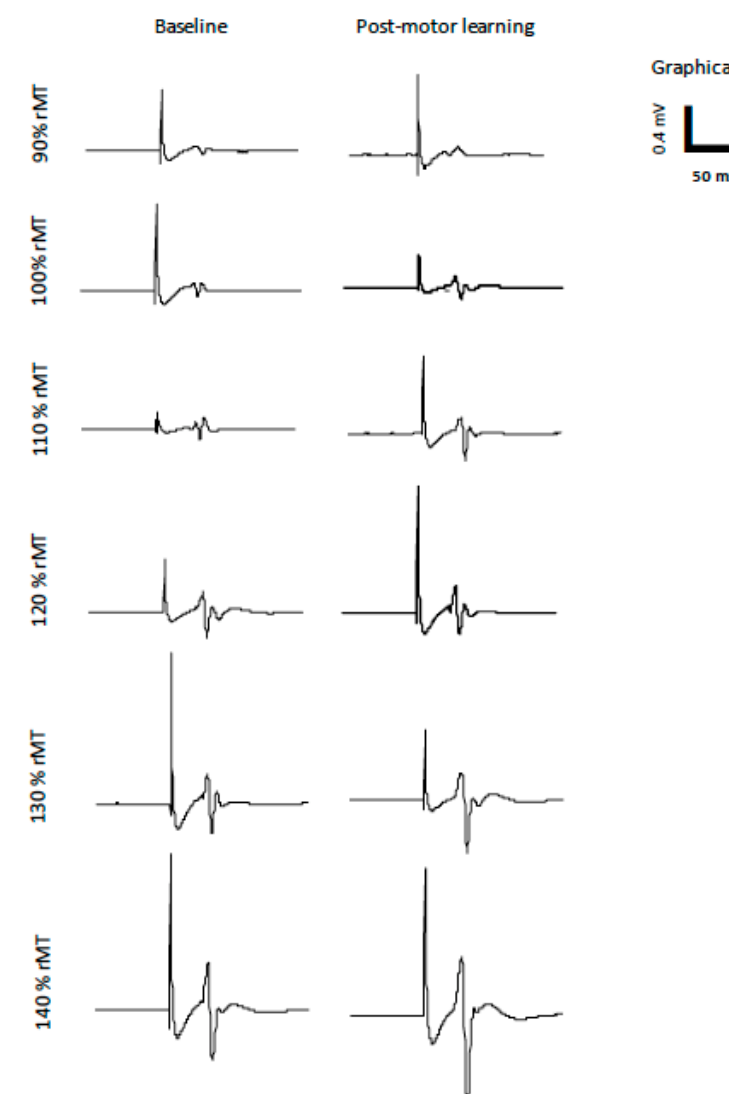
Figure 5. Average MEP data at baseline and post-motor learning from a representative control participant at all stimulation intensities (90% rMT–140% rMT). Table 2. Goodness of fit data (R 2 ) for the capsaicin and control groups at baseline, post-application, and post-motor learning acquisition.